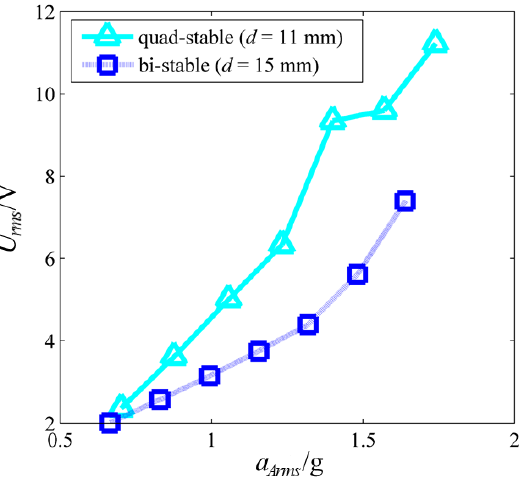
Figure 8. Experimental U rms − a Arms curves when a Arms falls within the range of 0.66 – 1.74 g.